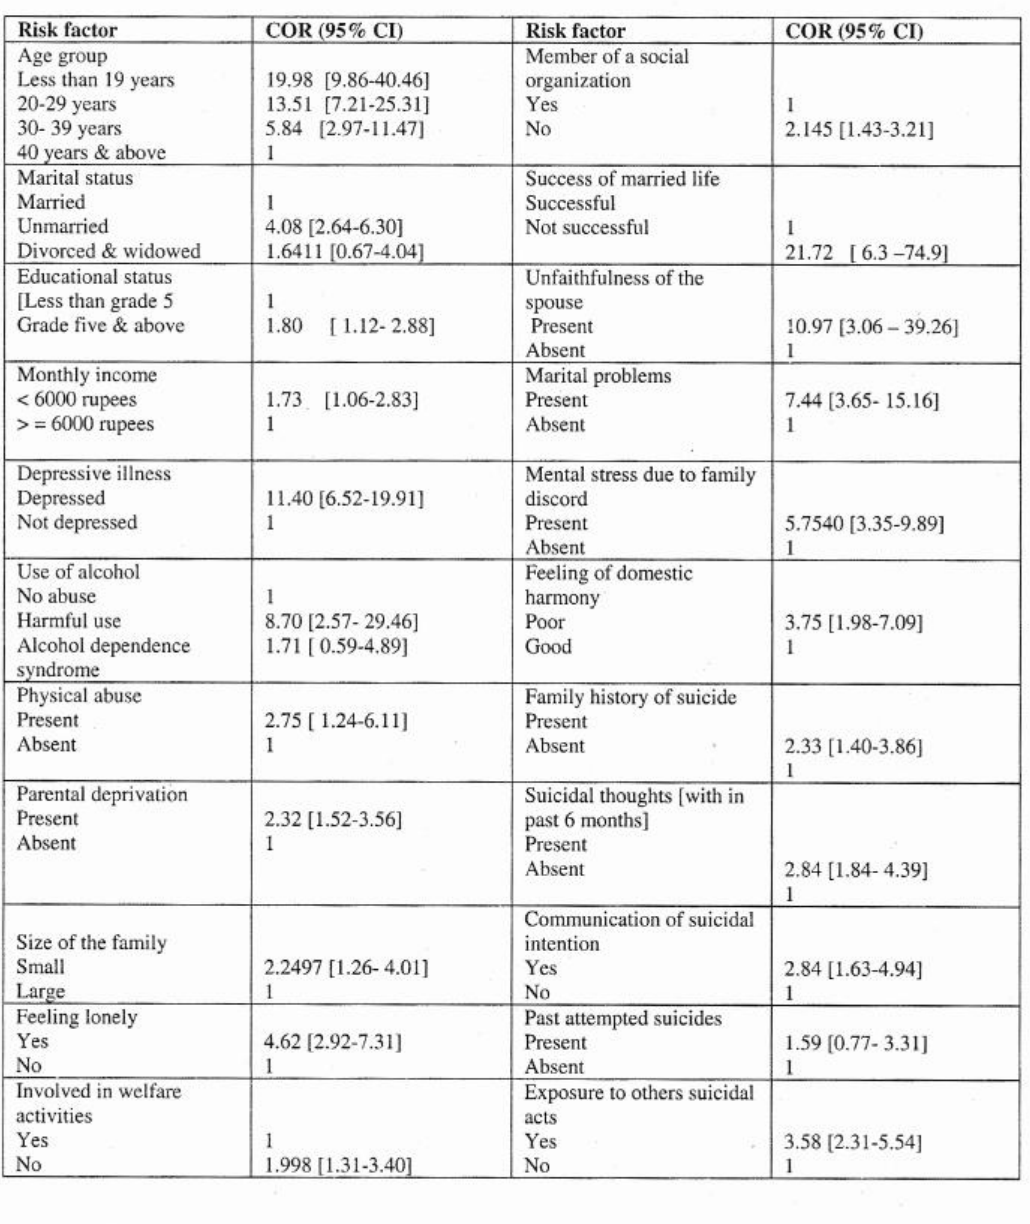
Table 3 : Association between predisposing factors andattempted suicide